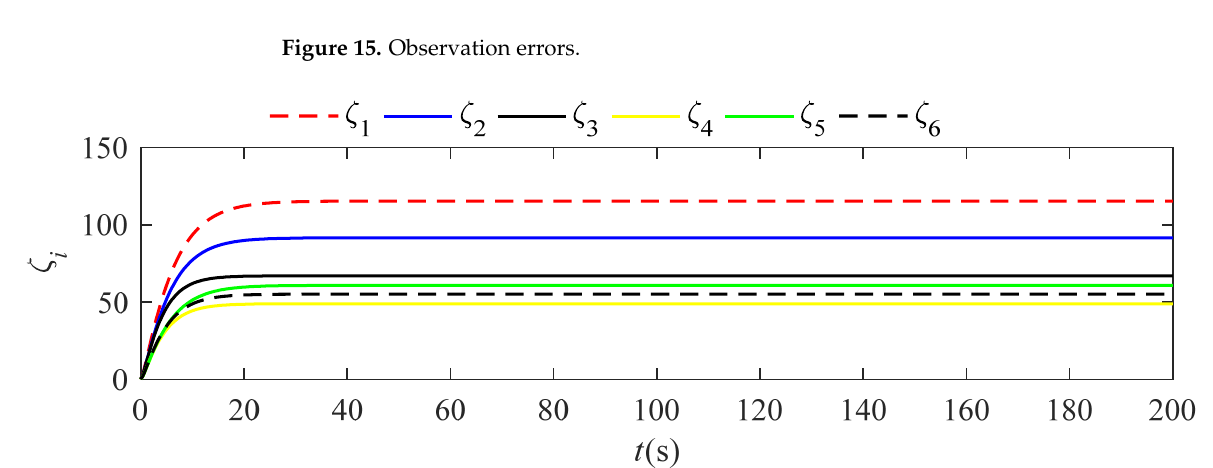
Figure 15. Observation errors.